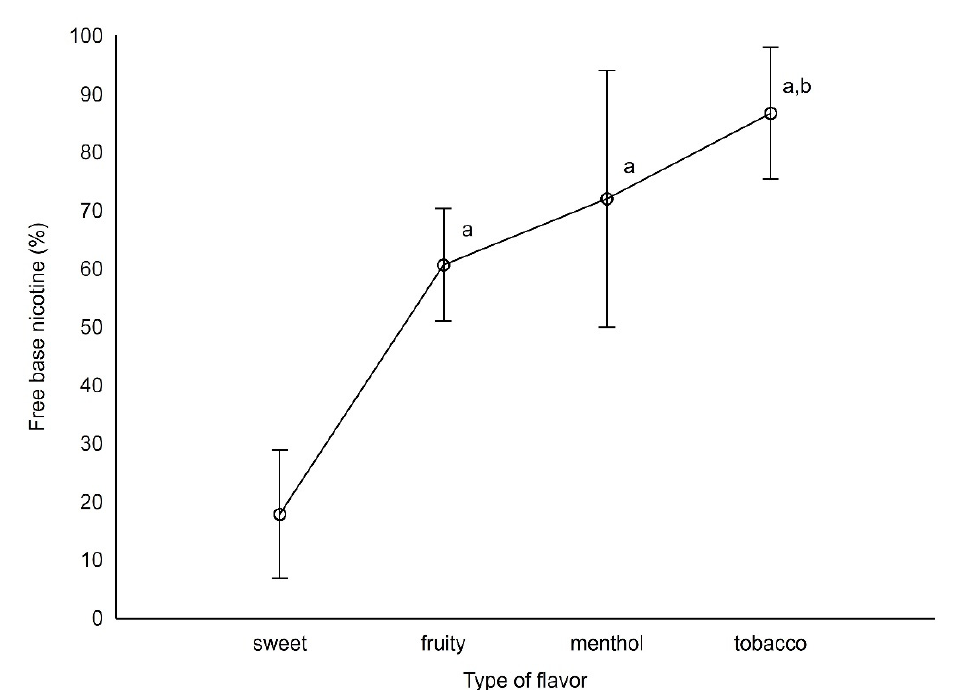
Figure 2. Differences in freebase nicotine content between different types of flavors. Liquids which differ statistically from sweet or fruity liquids were marked as a and b, respectively ( p < 0.05, Scheffe test). Table 3. Mean freebase nicotine content of different nicotine labeled refill solutions.